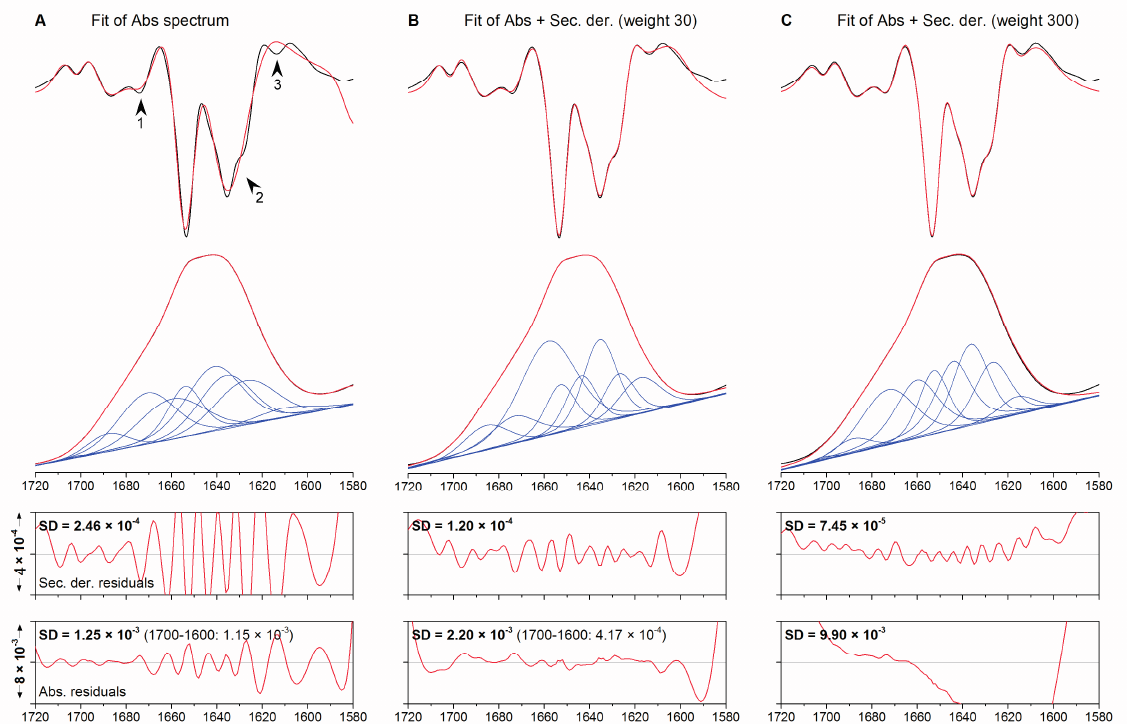
Figure 4. Fitting of the absorption spectrum of pyruvate kinase. ( A ) fitting of the absorption spectrum only; ( B , C ) simultaneous fitting of the absorption and second derivative spectra with weights of 30 and 300, respectively. From top to bottom: second derivative, absorption spectra and plots of the residuals. Original spectra are shown black, fitted spectra in red. The individual bands are shown in blue. Arrow heads denote noteworthy discrepancies between the experimental and fitted